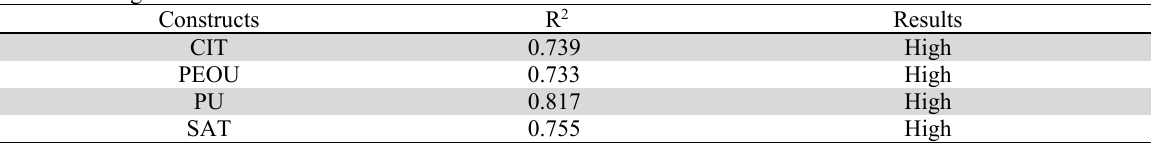
R 2 of the endogenous latent variables.